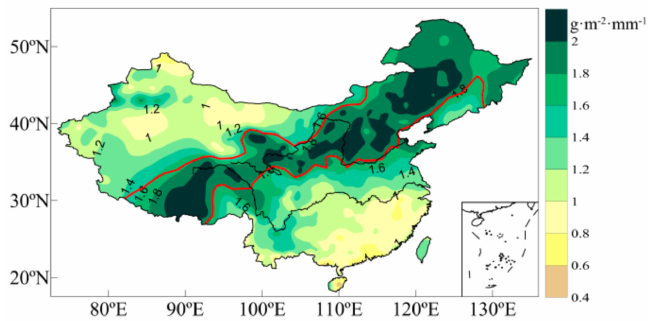
Figure 9. Spatial distribution of mean precipitation-use efficiency (PUE) in China during 1981–2010.